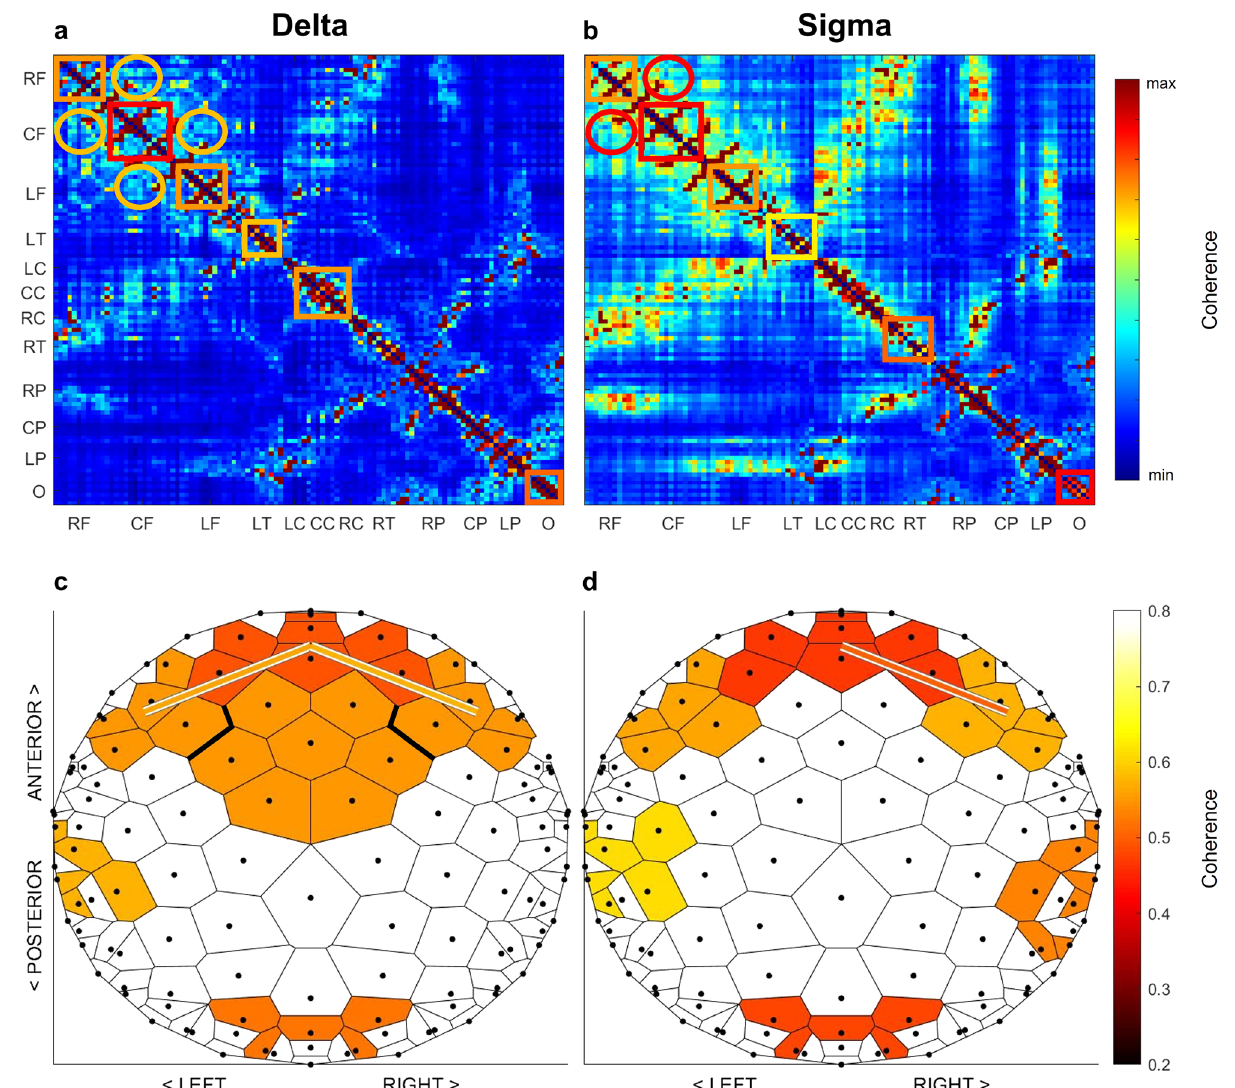
5886 connections were grouped into the following regions: right frontal (RF), central frontal (CF), left frontal (LF), left temporal (LT), left central (LC), central central (CC), right central (RC), right temporal (RT), right parietal (RP), central parietal (CP), left parietal (LP), occipital (O). Cool colors (blue) represent lower coherence, while warm colors (red) represent greater coherence. Colored squares correspond to color-matched functional units shown in ( c,d ). Circles depict the connections corresponding to the lines between the units in ( c,d ). The units and their connections were detected through a data-driven clustering approach, such that regions exhibiting the greatest levels of coherence were detected. Colors depict the level of coherence averaged across subjects with brighter color tones indicating higher values. Same-color units are separated by means of bold